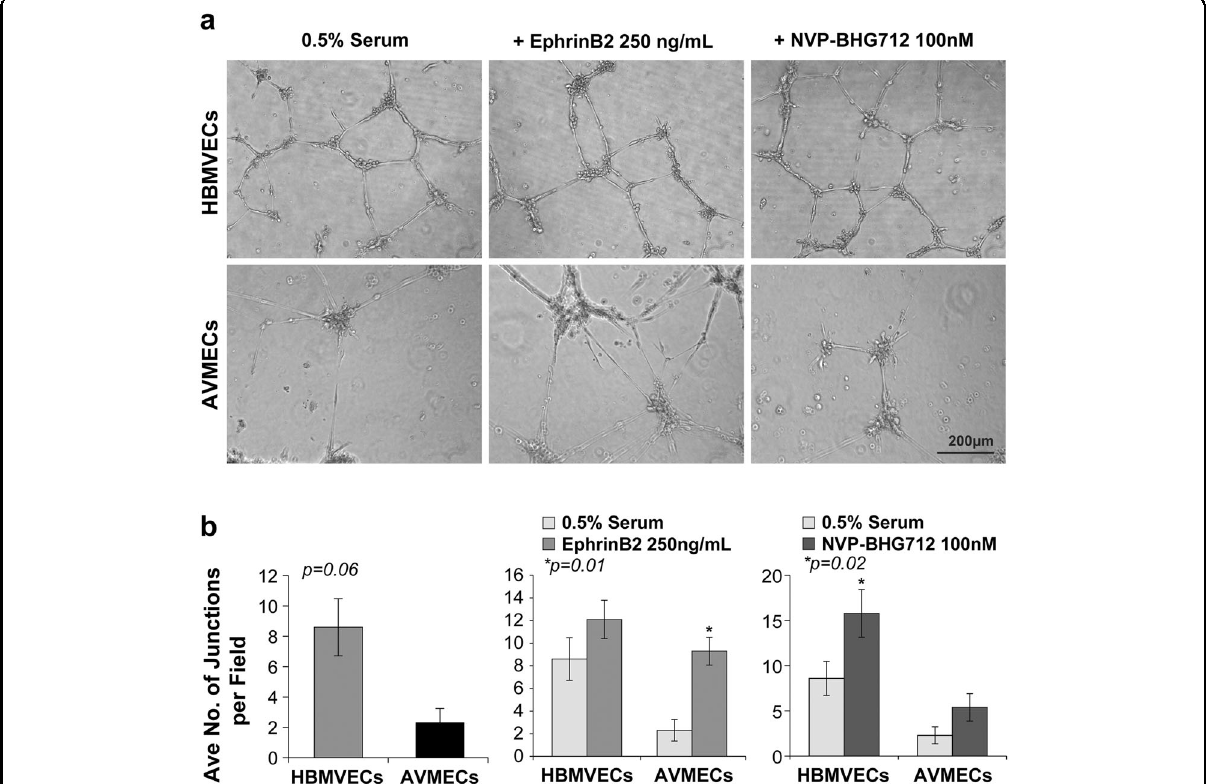
Fig. 4 Altering the EphrinB2 to EphB4 ratio results in increased tube formation in HBMVECs and increases the rate of disorganized AVMEC tube formation with redundant sprouting. At baseline, AVMECs exhibit poor tube formation relative to that of controls. This can be seen qualitatively by incomplete tube formation and sprouting ( a ) as well as quantitatively by the number of completed junctions ( b ). Augmenting the EphrinB2/EphB4 ratio by stimulating with exogenous EphrinB2 increases the number of junctions (* p = 0.01) ( b ), although sprouting is redundant and disorganized compared to that of HBMVECs ( a ). Inhibition of EphB4 does not alter AVMEC tube formation (these cells are known to have low endogenous EphB4 expression); EphB4 inhibition subtly but consistently increases the total number of completed junctions in HBMVECs (* p = 0.02).